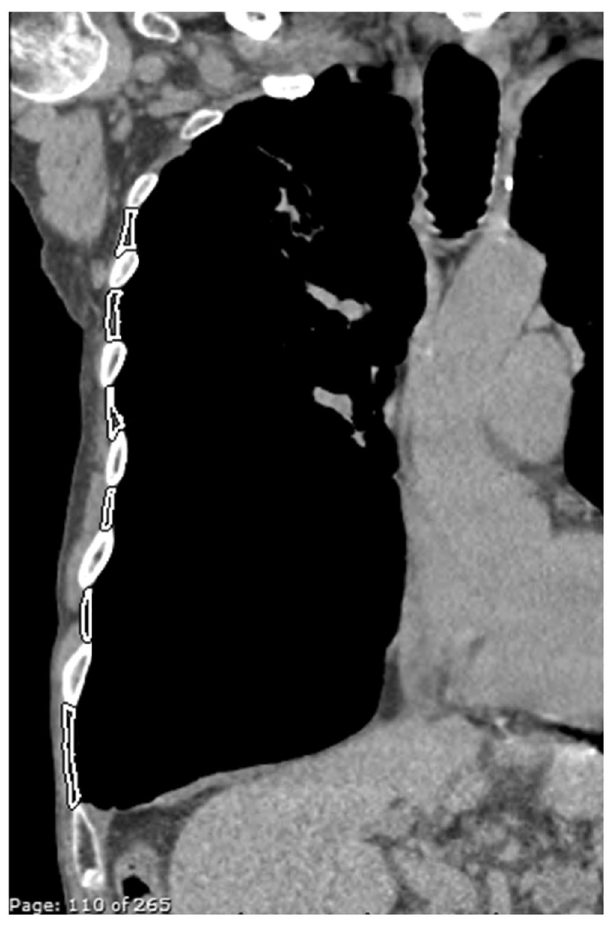
Figure 4. CT image of lateral chest wall internal intercostal muscles. Coronal image from chest CT at lateral arc of 1 st rib with ROI surrounding boundaries of 3 rd –8 th internal intercostal muscles.